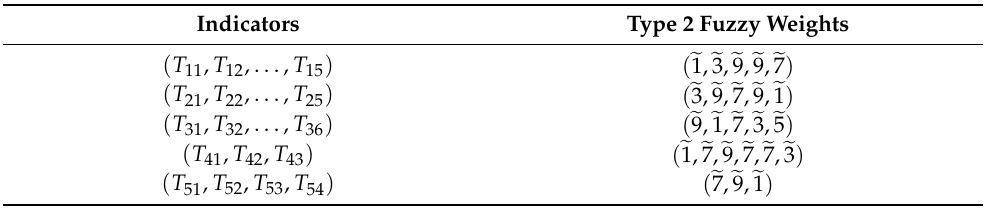
Table 4. The indicator weights given by evaluation experts.